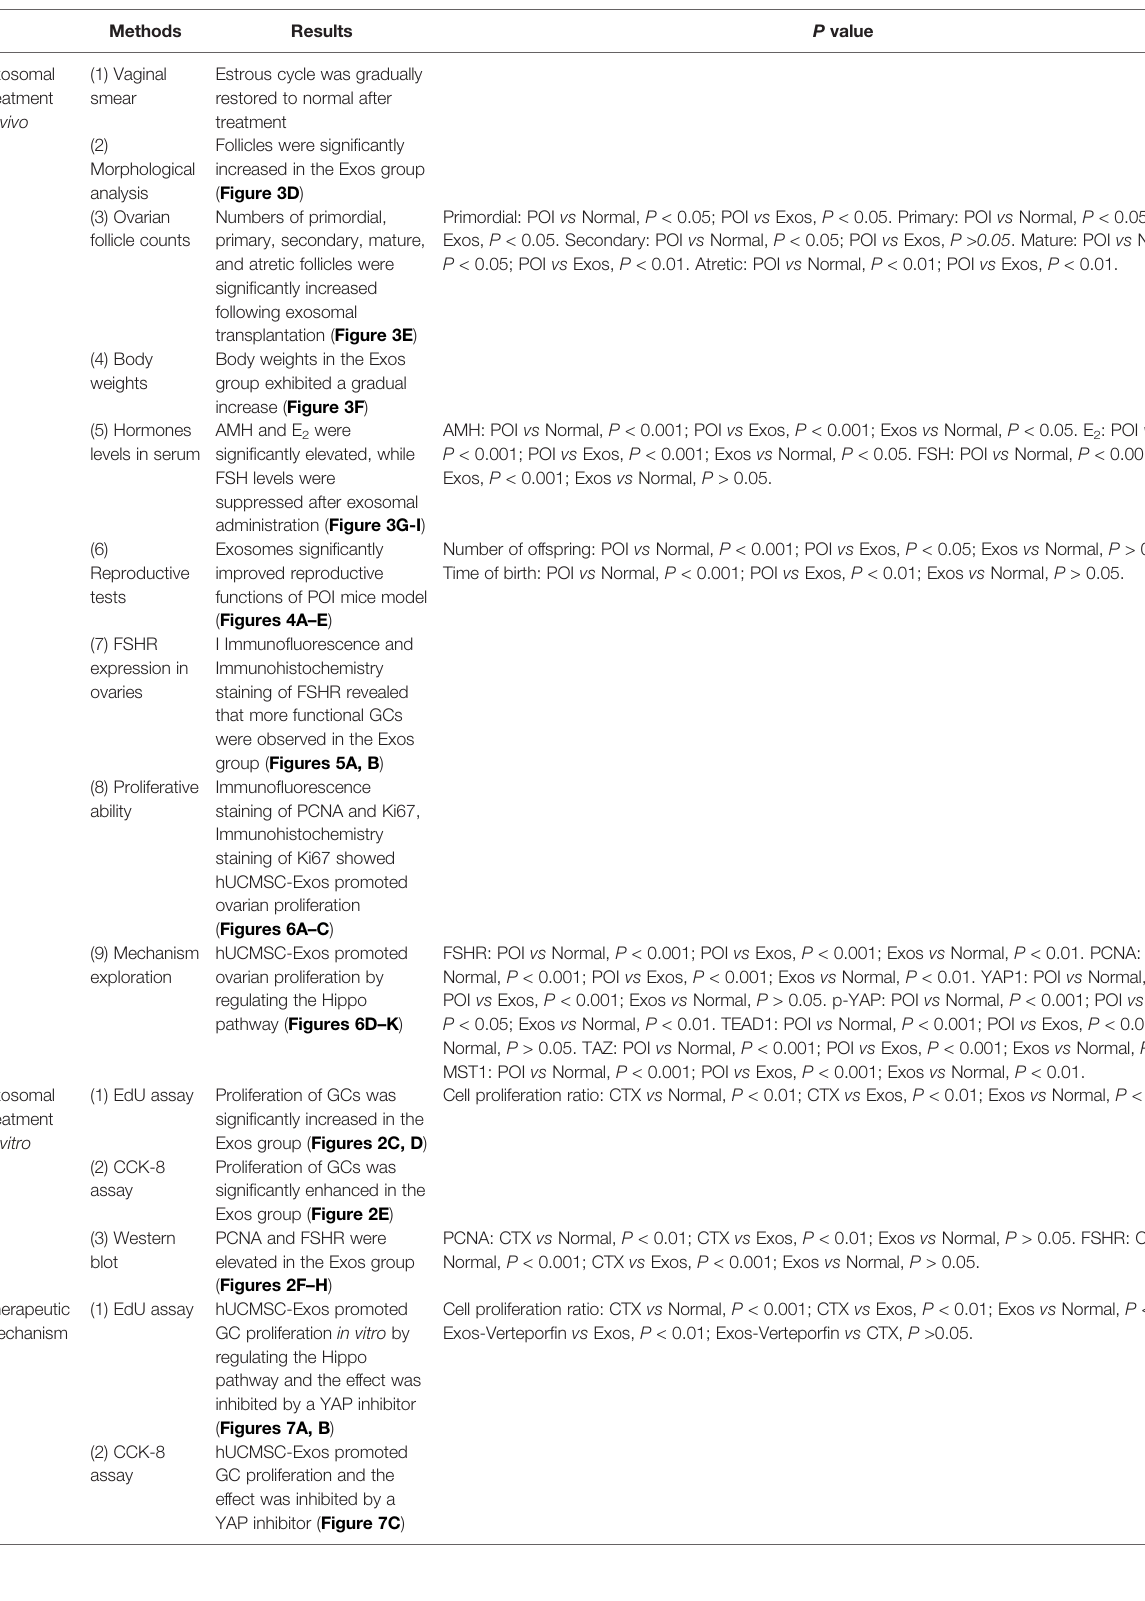
TABLE 2 | Results of hUCMSC-Exos